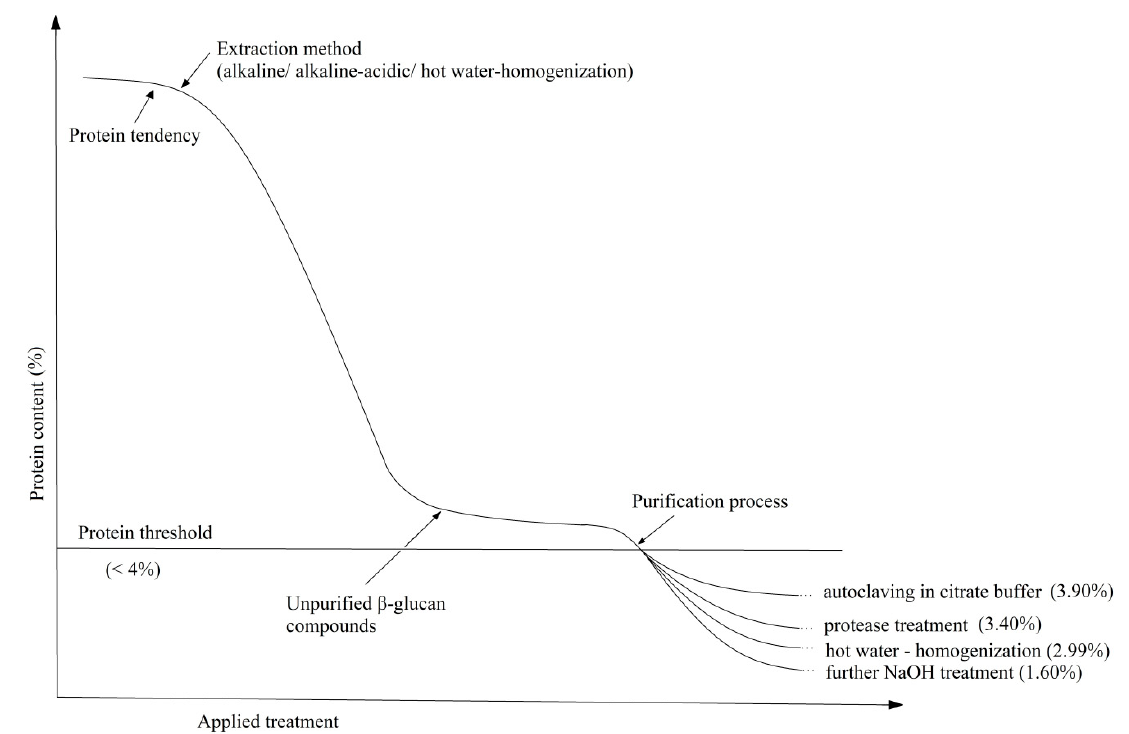
Figure 5. Schematic representation of protein content during β -glucan extraction.